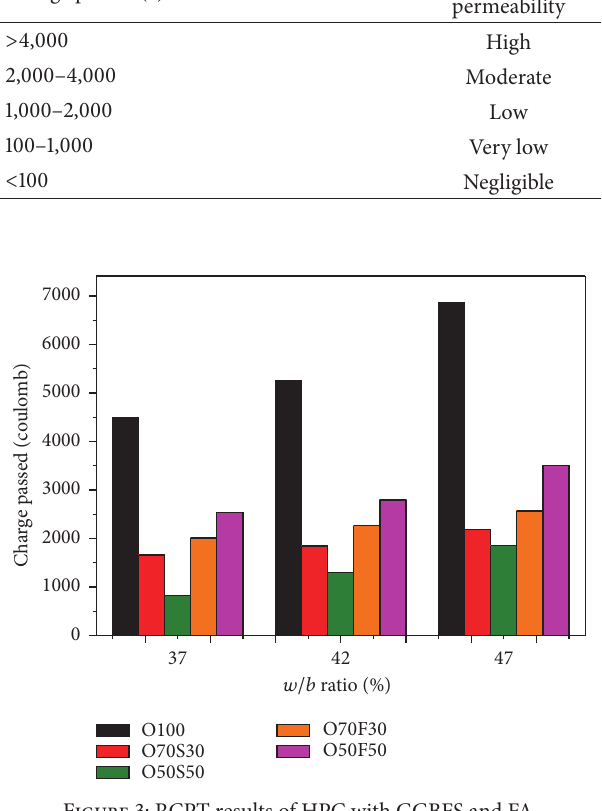
GGBFS in HPC (0.37% of 𝑤/𝑏 ) had lesser coulomb